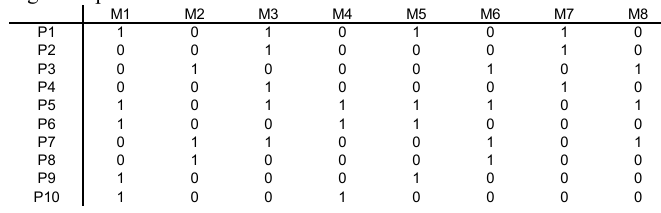
Figure 7. part-machine matrix M1